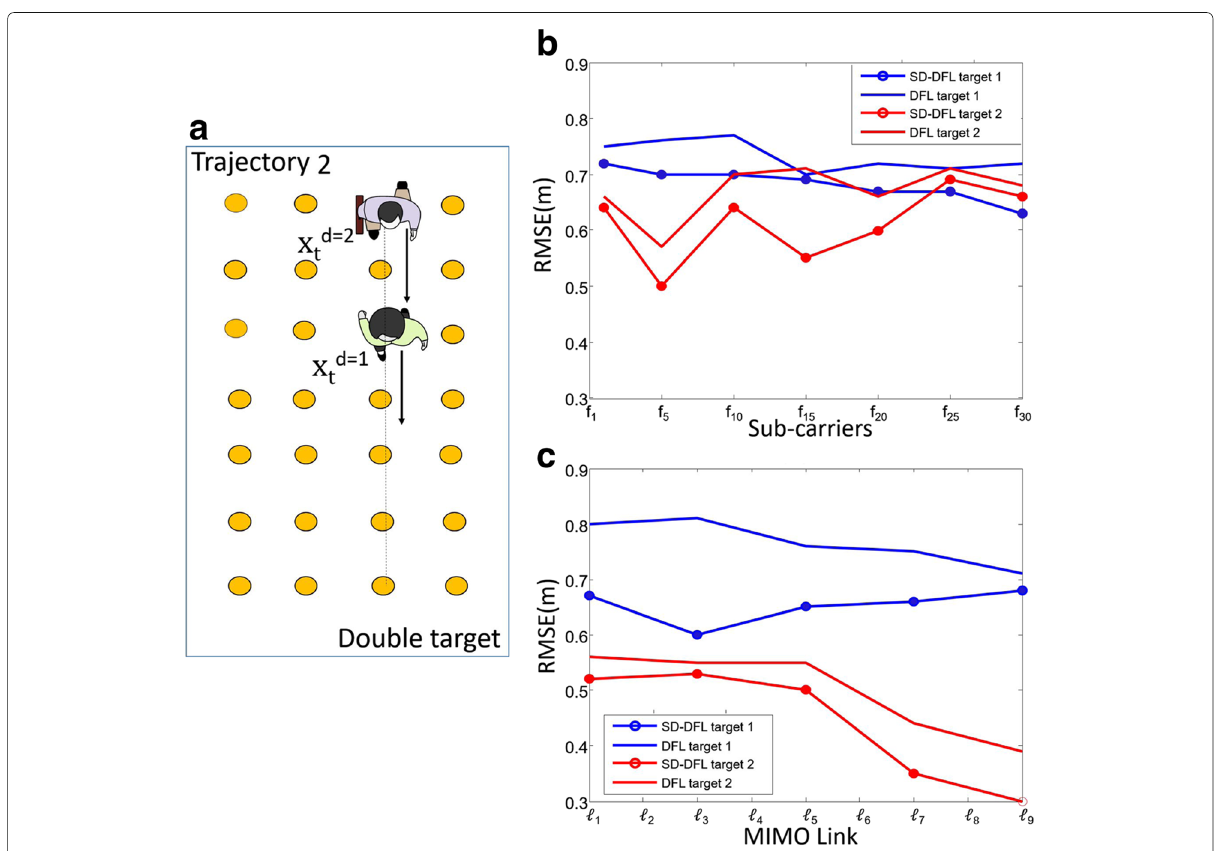
Fig. 10 Double target scenario. a Target d = 2 is standing, and target d = 1 is localized while moving on the highlighted trajectory #2. b Positioning RMSE for target d = 1, 2 vs. sub-carriers using space-domain CSI profiles for Bayesian DFL and SD-DFL methods. c Positioning RMSE for target d = 1, 2 vs. MIMO links. Both Bayesian DFL and SD-DFL methods are